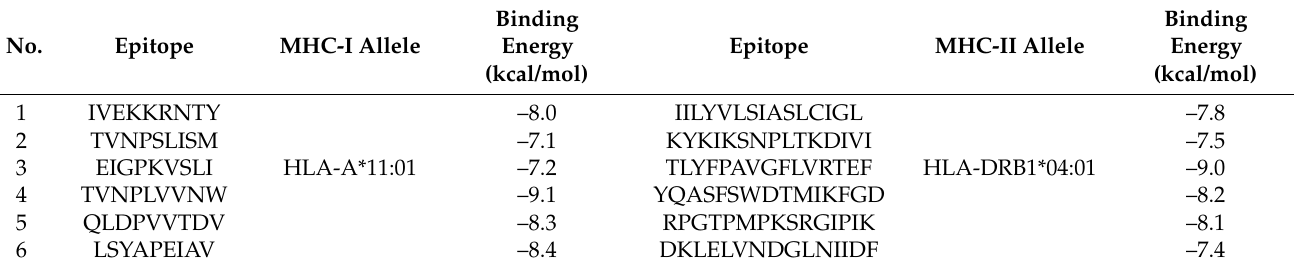
Table 7. The binding energy of T cell epitopes with their respective